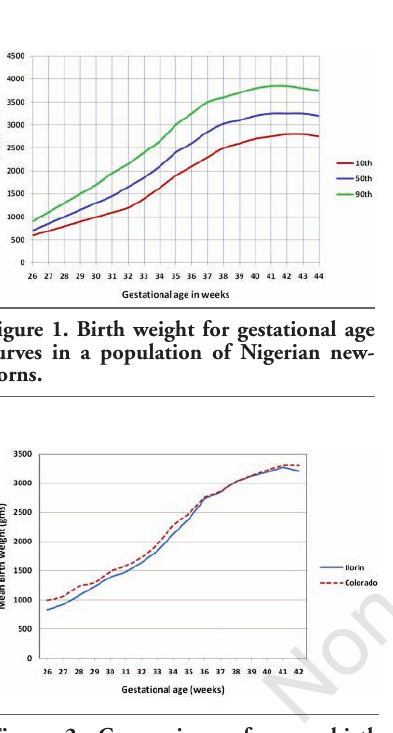
Figure 2. Comparison of mean birth weights between Ilorin and Colorado.